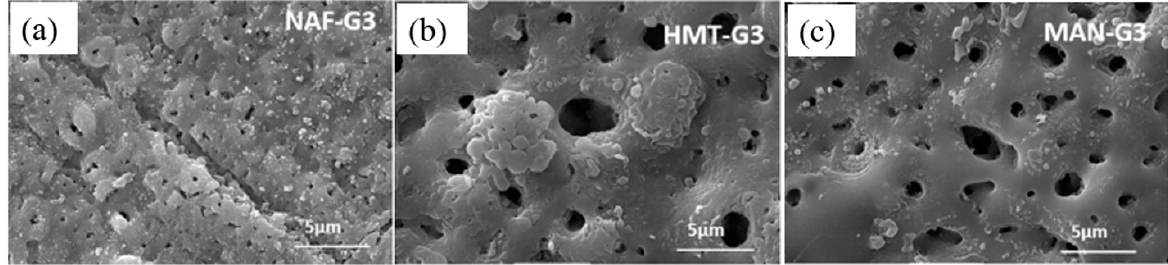
Figure 7. ( a – c ) SEM images of the PEO coatings made on pure magnesium from electrolyte ( a ) with NaF, ( b ) with hexa- methylenetetramine (HMT), and ( c ) with mannitol (MAN). Reprinted from permission from [101]. Copyright 2018 Else- vier.